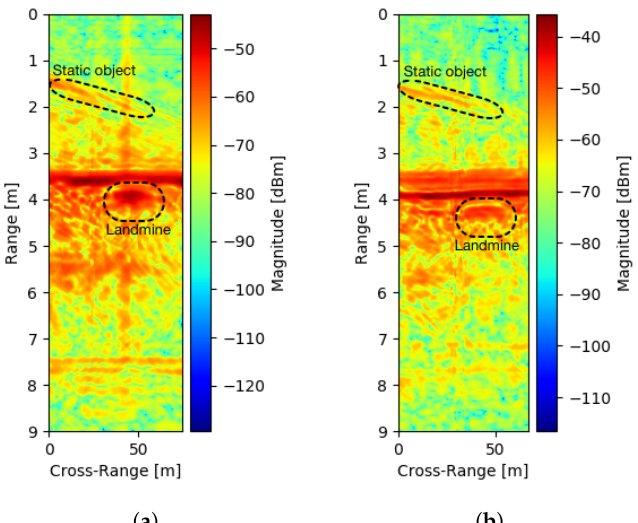
Figure 12. B-Scan with 20 cm deep buried metal AP landmine of size 8 cm × 17 cm in dry mixed soil and antenna to ground distance is 20 cm ( a ) and 45 cm ( b